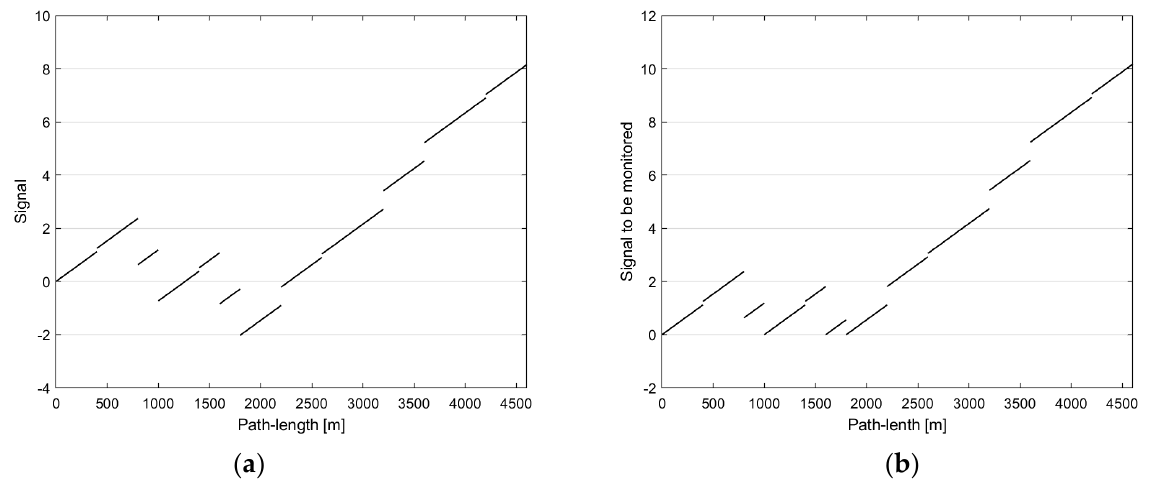
Figure 1. A downtown (Dt) → residential (Res) change detector applied to a homologous road environment type (RET) transition showing up in the traffic sign (TS) sequence given in the top band of Table 2: ( a ) Function g Dt → Res considered TS sequence and ( b ) Function h Dt → Res →